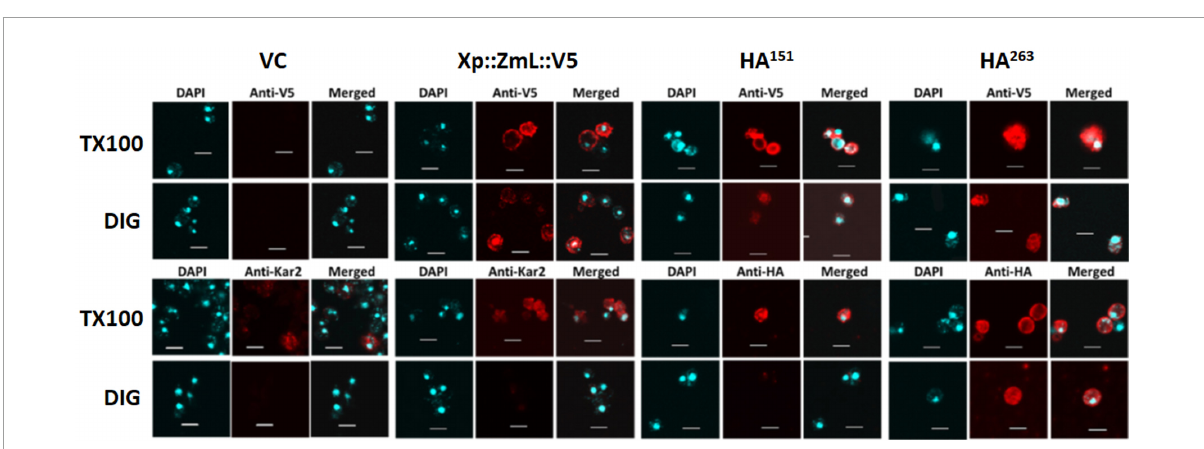
FIGURE6 Differential permeabilization analysis of S. cerevisiae cells expressing VC, Xp::ZmL::V5, Xp::ZmL-HA 151 ::V5 and Xp::ZmL-HA 263 ::V5. Nuclei of individual cells were visualized by DAPI stain. As expected, the ER lumen marker protein Kar2 was visualized after treatment with triton X-100 (TX100) but not digitonin (DIG). After treatment with DIG and probing with the V5 antibody the majority of cells had a faint signal; however, the signal was much stronger when the cells were treated with TX100. The HA signal on HA 151 was not detected when the cells were pre-treated with DIG but was detected after pre-treatment with TX100 whereas the HA signal on HA 263 was detected after the addition of either detergent. Combined, the results concur with the protease protection assay and indicate the C-terminus and the internal residue 151 on ZmL DGAT1 are located in the membrane compartment while the internal residue 263 is located in the cytoplasm. Scale bar = 5 µ M.